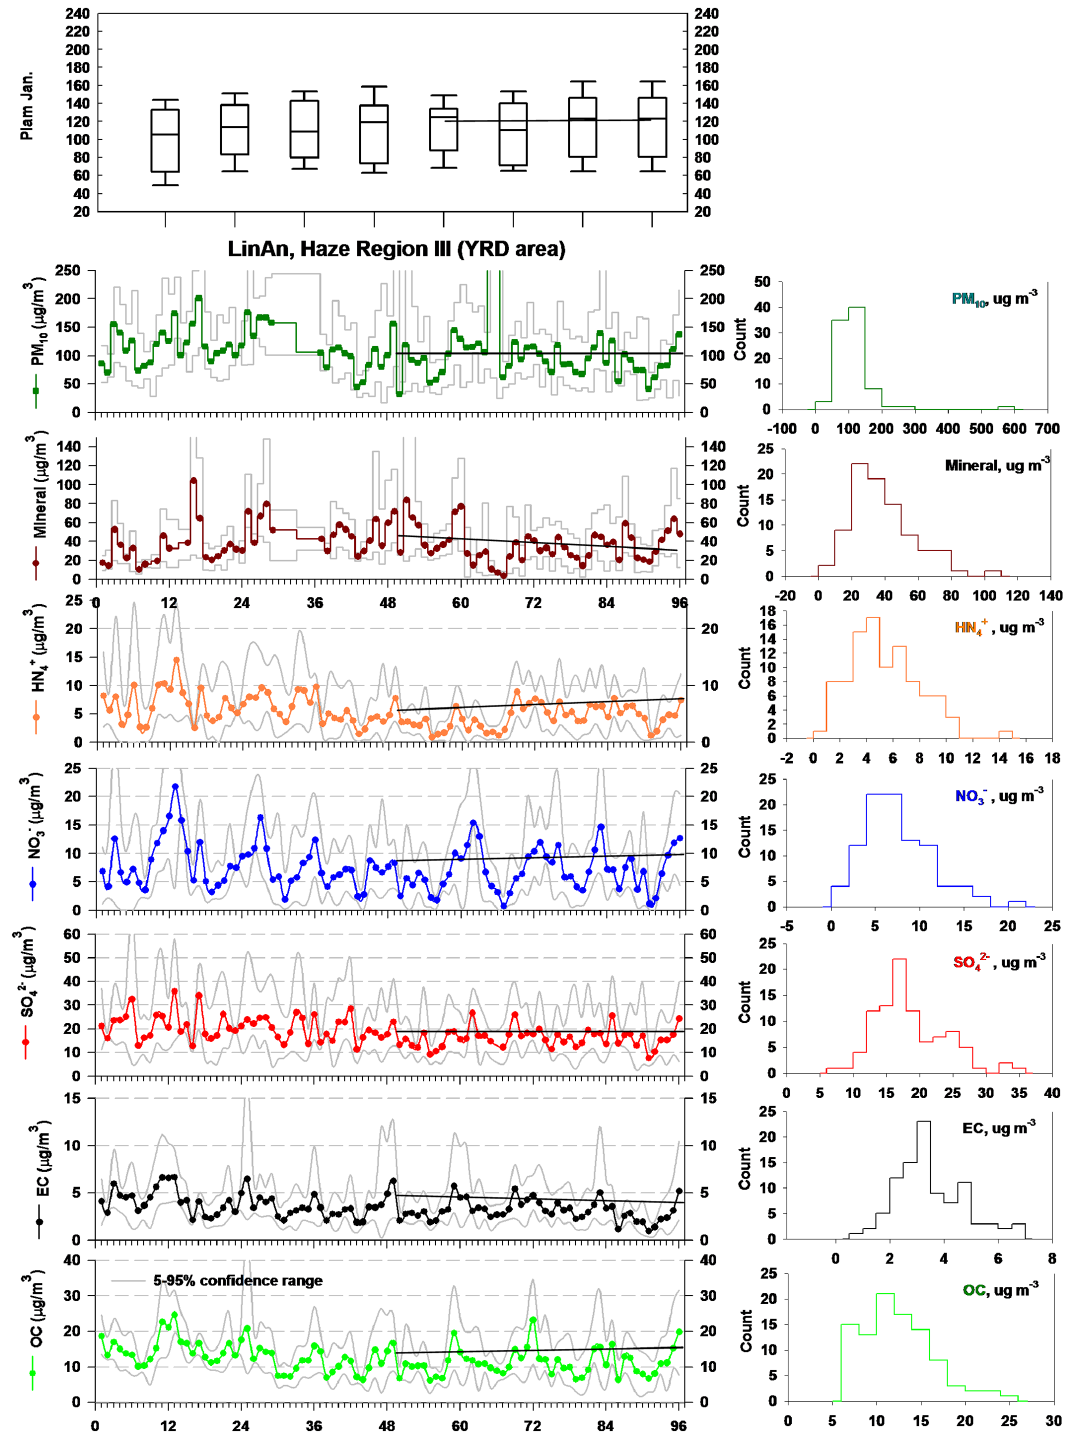
Figure 4. Left panel: change of monthly median concentrations of major chemical components, PM 10 , and January PLAM at LinAn in haze region III, one of the major haze region in the Yangtze River Delta (YRD) area in China. Wintertime data were used in linear trend fitting from 2010 to 2013; right panel: histogram analysis result for various chemical